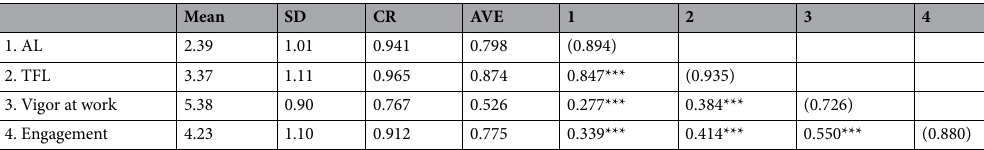
Table 1. Descriptive statistics, correlations, reliability, convergent and discriminant validity values. AL = Authentic leadership; TFL = Transformational leadership; SD = Standard deviation; CR =